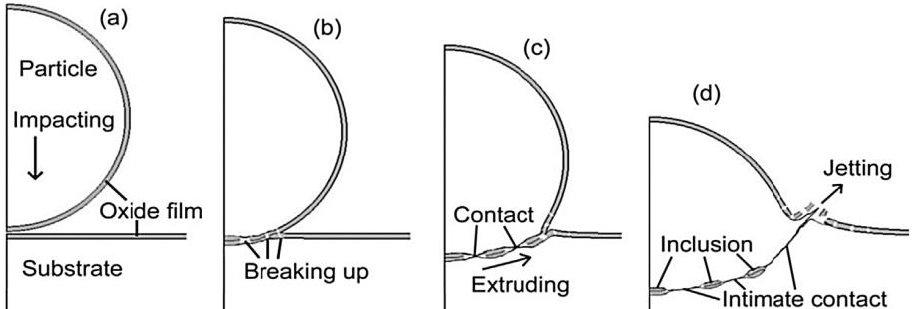
Figure 16. Schematic representation of the cold spray deposition process ( a ) impacting, ( b ) break up, ( c ) extruding, ( d ) inclusion [205].